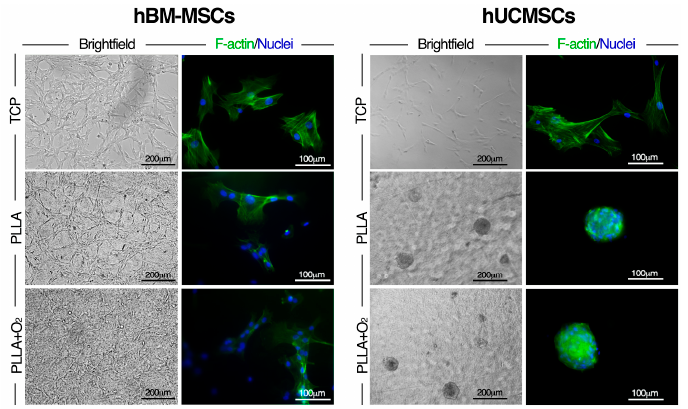
Figure 7. Effect of oxygen-plasma treatment to PLLA on hBM-MSCs and hUCMSCs cultures. Representative brightfield and immunofluorescence images of hBM-MSCs and hUCMSCs cultured on TCP, PLLA, and PLLA+O 2 , respectively. F-actin (Phalloidin-FITC, green) and nuclei (DAPI, blue).